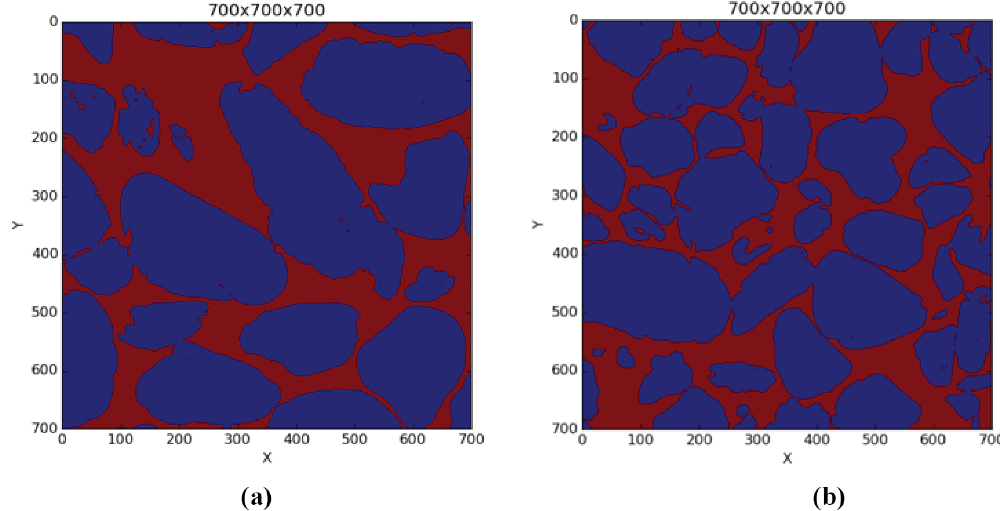
Figure 7. An example of 700 3 binary images for (a) Scarborough and (b) Cottesloe beaches.